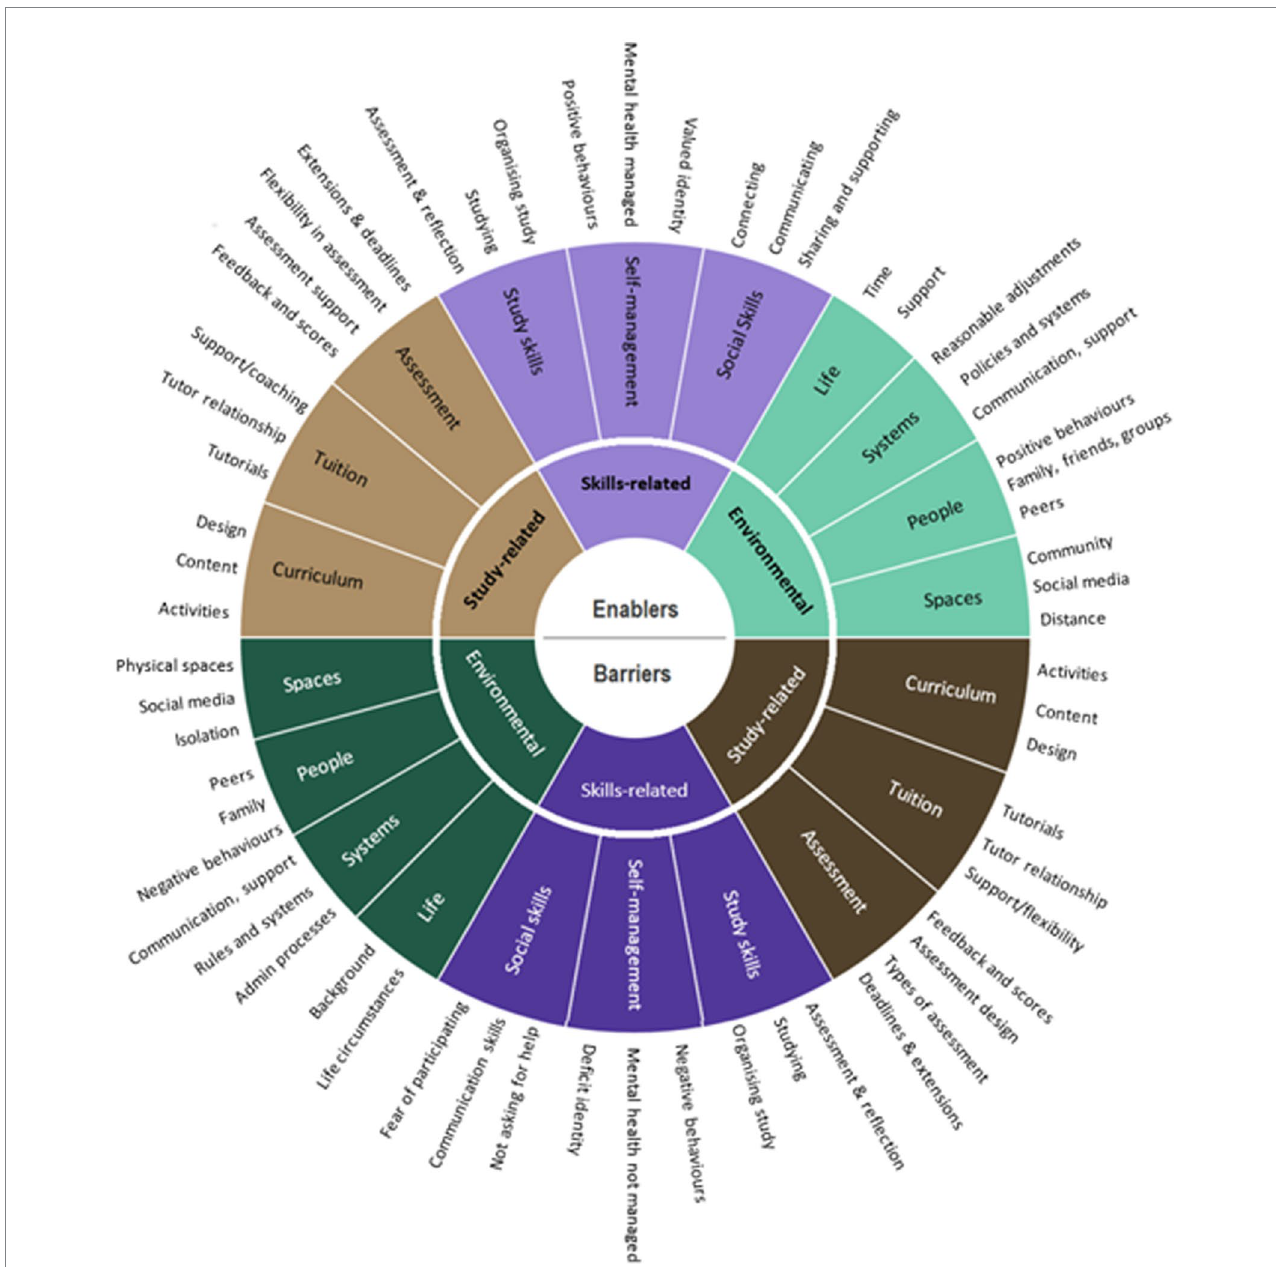
FIGURE 3 Taxonomy of barriers and enablers to mental wellbeing in study. Figure copyright: Kate Lister, Jane Seale & Chris Douce (CC-BY